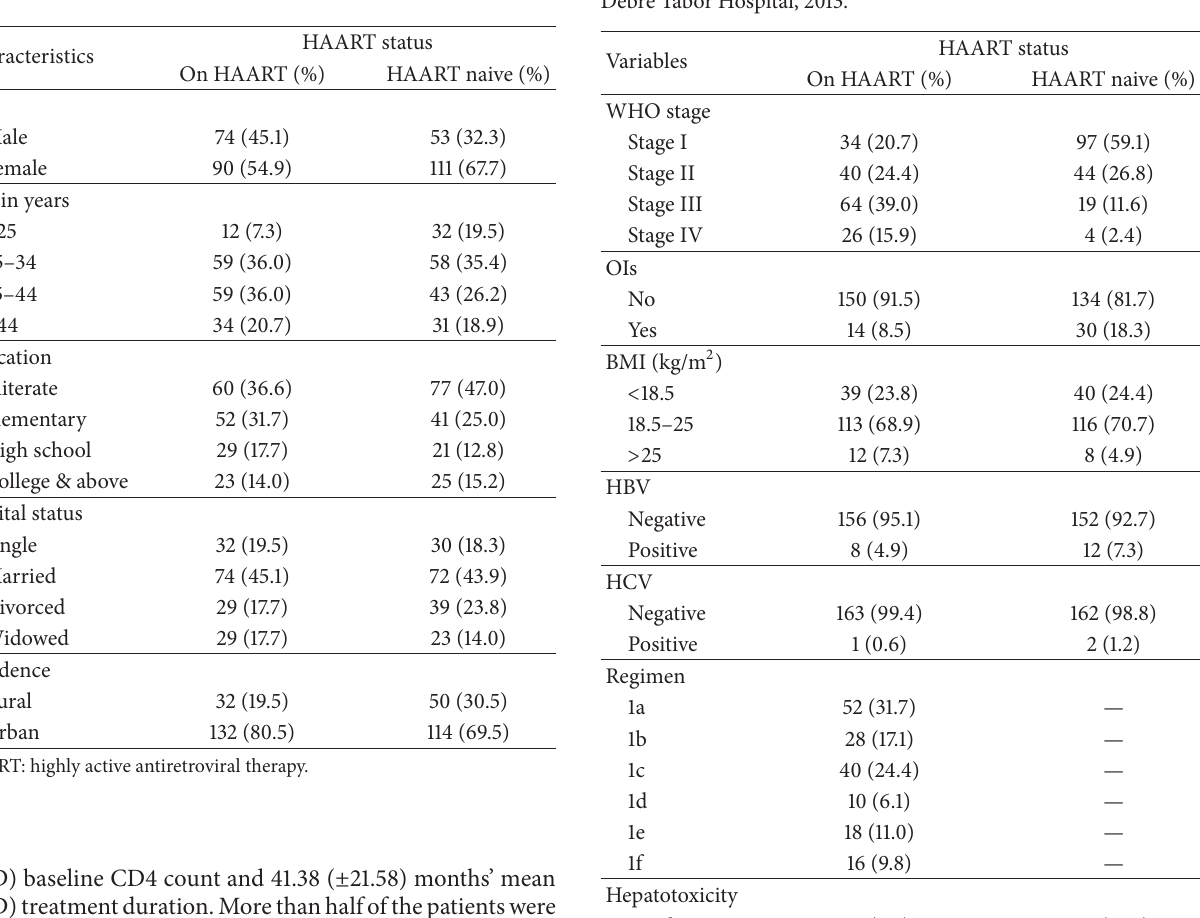
Table 1: Sociodemographic characteristics of study participants, 2013.